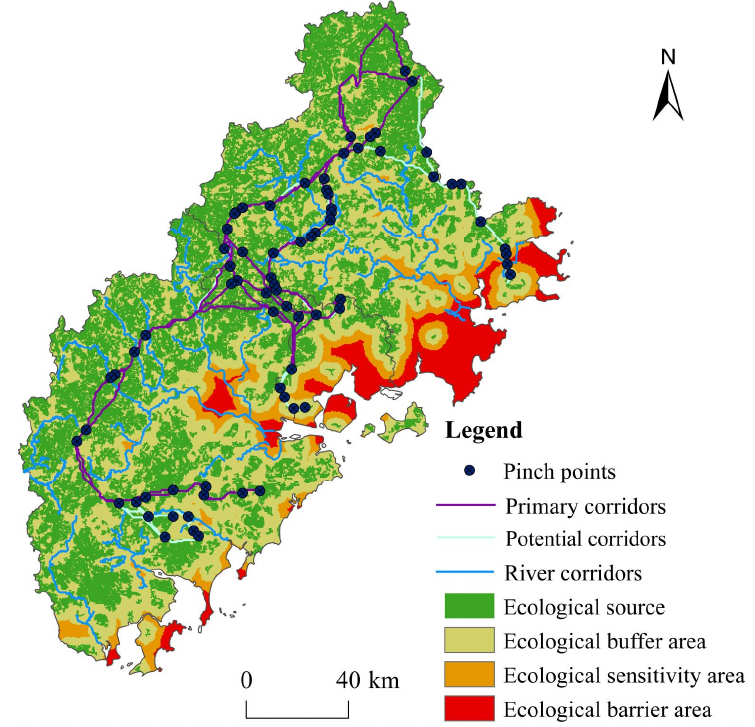
Figure 5. Spatial distribution map of ecological security patterns.